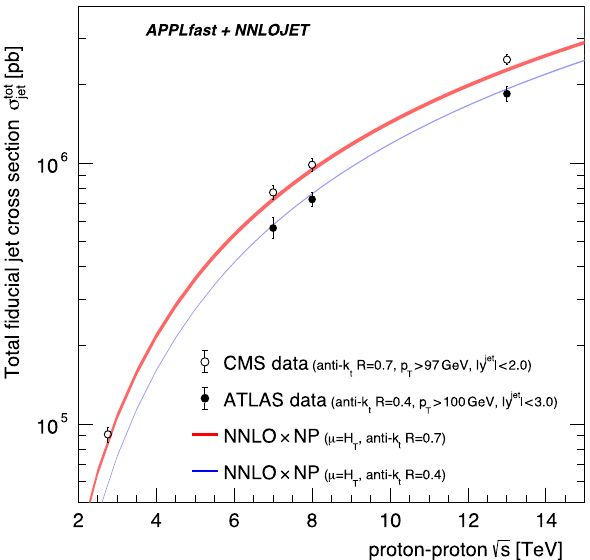
Fig. 6 The total jet cross section as a function of the proton–proton centre-of-mass energy for anti- k T jets with R = 0 . 4 and 0.7. The pre- dictions are compared to data from ATLAS (for R = 0 . 4) and CMS (for R = 0 . 7), and the fiducial region is selected according to the avail- able data. The size of the shaded area indicates the scale uncertainty, evaluated as described in the text